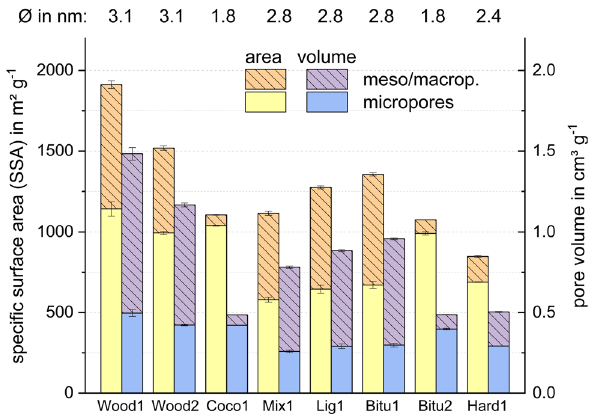
Fig. 2 Specific surface area (SSA) and total pore volume of the eight PACs with respective shares of mesopores, macropores, and micropo- res, with average pore diameters (4 V/A) on